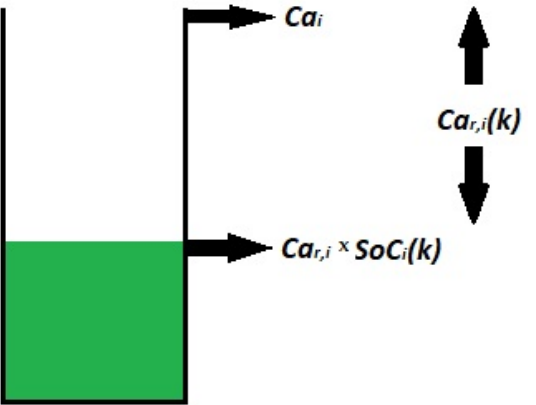
Figure 2. Illustration of ba tt ery charging of PHEV [23].